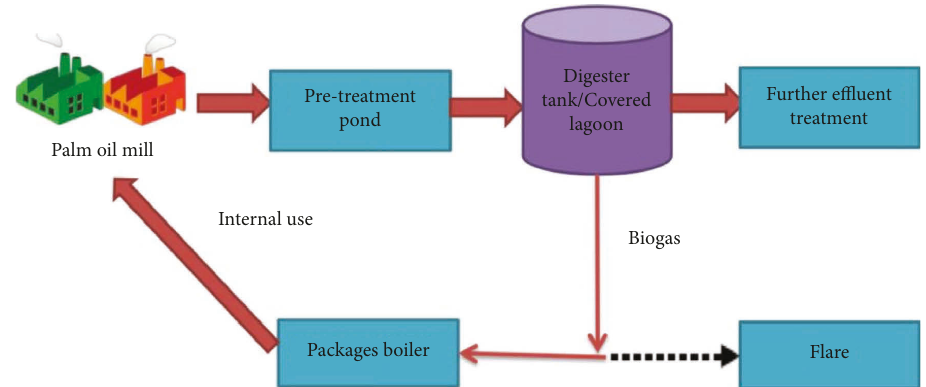
Figure 3: Process flow diagram for biogas captured and used in package boiler